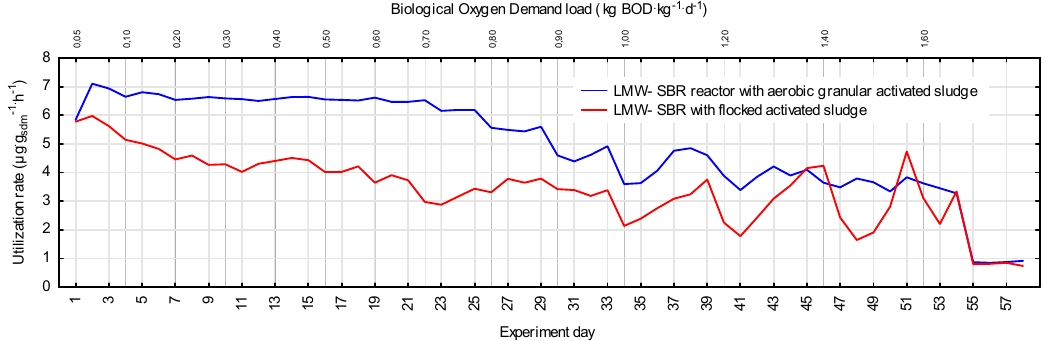
Figure 3. Sum of low molecular weight polycyclic aromatic hydrocarbons ( Σ LMW) utilization rate in anaerobic